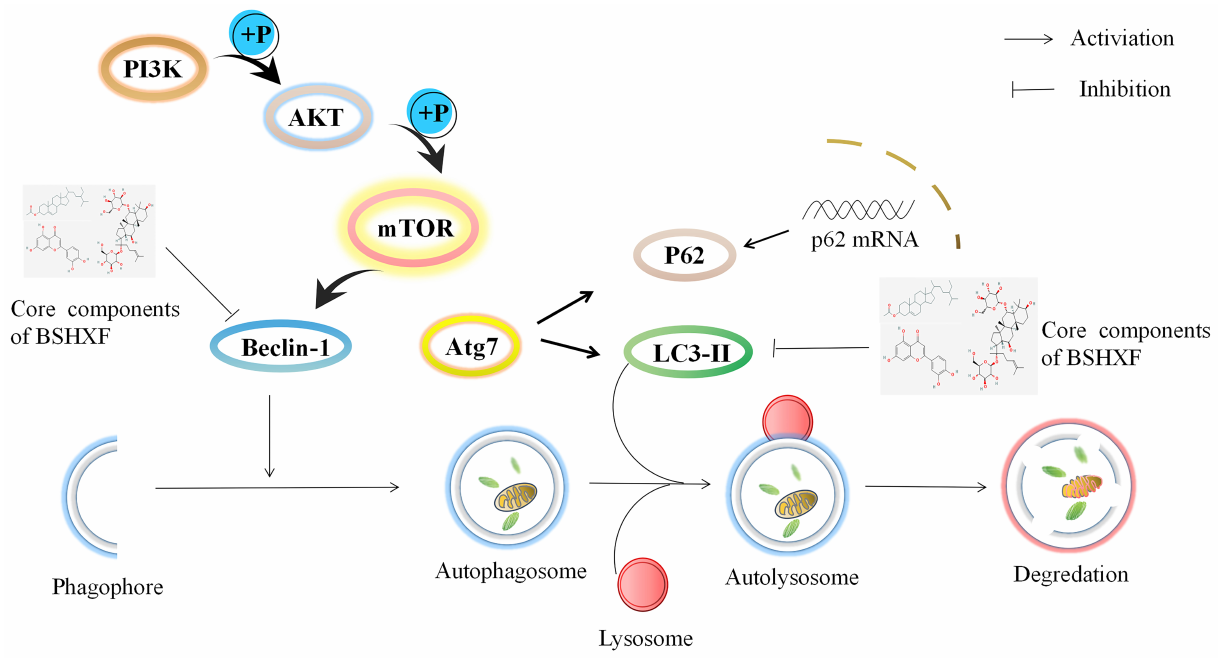
Fig. 10. Schematic diagram of the action mechanism of the core compounds related to autophagy in BSHXF. Core components of BSHXF inhibit autophagy during VD treatment. Its mechanism is closely related to the decrease of Beclin-1 and LC3 protein expression and increase of P62 expression in the